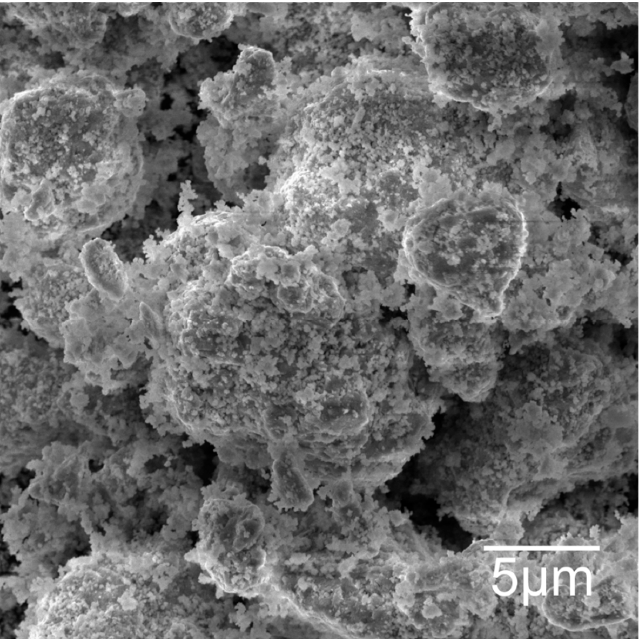
Figure 4. SEM microphotographs of Ti35Mo + 10% yttria-stabilized zirconia (YSZ) + 1% Y 2 O 3 powder after mixing.